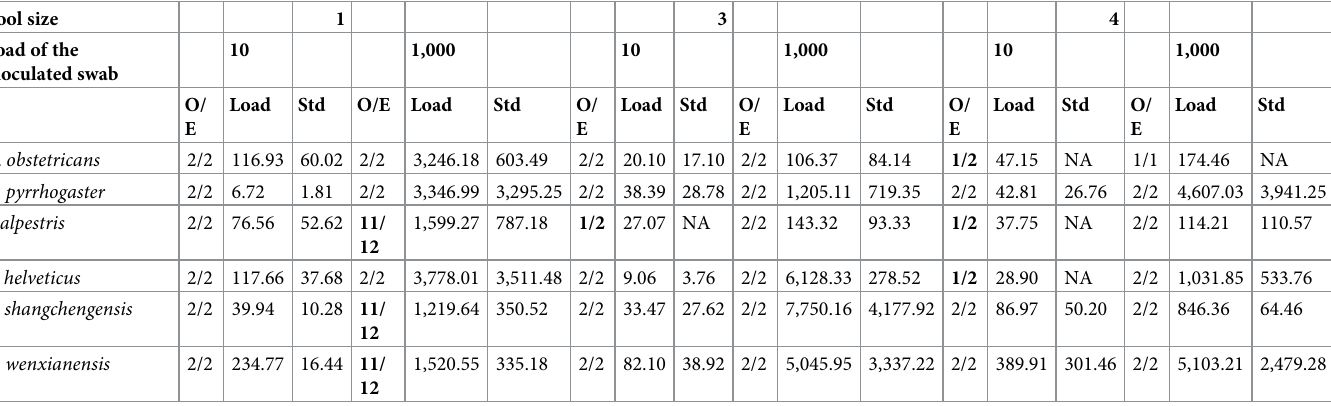
Table 2. Zoospore counts for Experiment